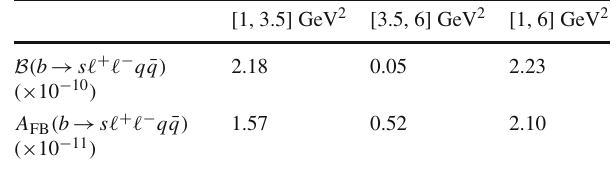
Table 1 Numerical estimates for the branching ratio and the forward- backward asymmetry of b → d (cid:2) + (cid:2) − q ¯ q in the low- q 2 region